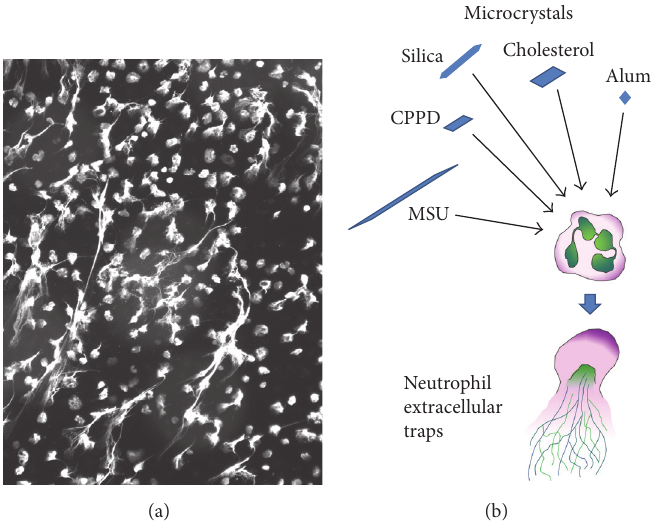
Figure 1: Neutrophil extracellular traps. (a) This fluorescent image depicts NETs released from human PMNs following CPPD crystal stimulation (50 𝜇 g/mL, 3 hrs, unpublished data). PMN DNA was stained by DAPI and the color was artificially turned into white for better visibility. (b) Scheme demonstrating different types of microcrystals that were documented to release DNA from